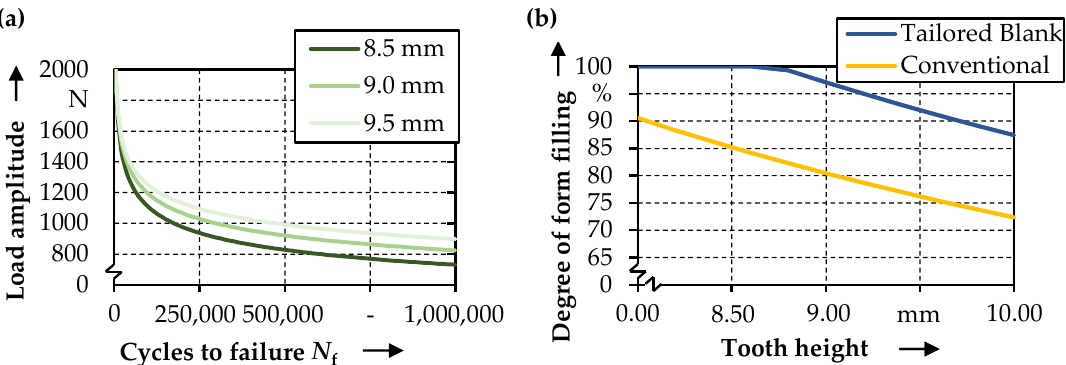
Figure 16. ( a ) Resulting curves for different tooth heights predicted by the trained metamodel, and ( b ) the predicted degree of form filling for a conventional and a tailored blank.